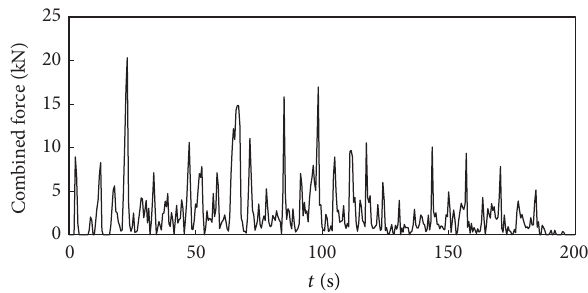
Figure 14: Time history curve of the combined force on cutting head.